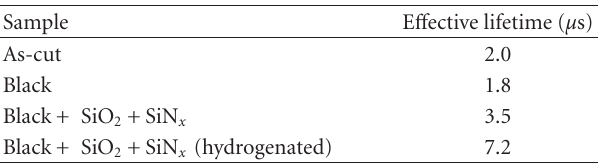
Table 1: E ff ective minority carrier lifetime of Si solar wafers. Sample E ff ective lifetime ( μ s) As-cut 2.0 Black 1.8 Black + SiO 2 + SiN x 3.5 Black + SiO 2 + SiN x (hydrogenated)